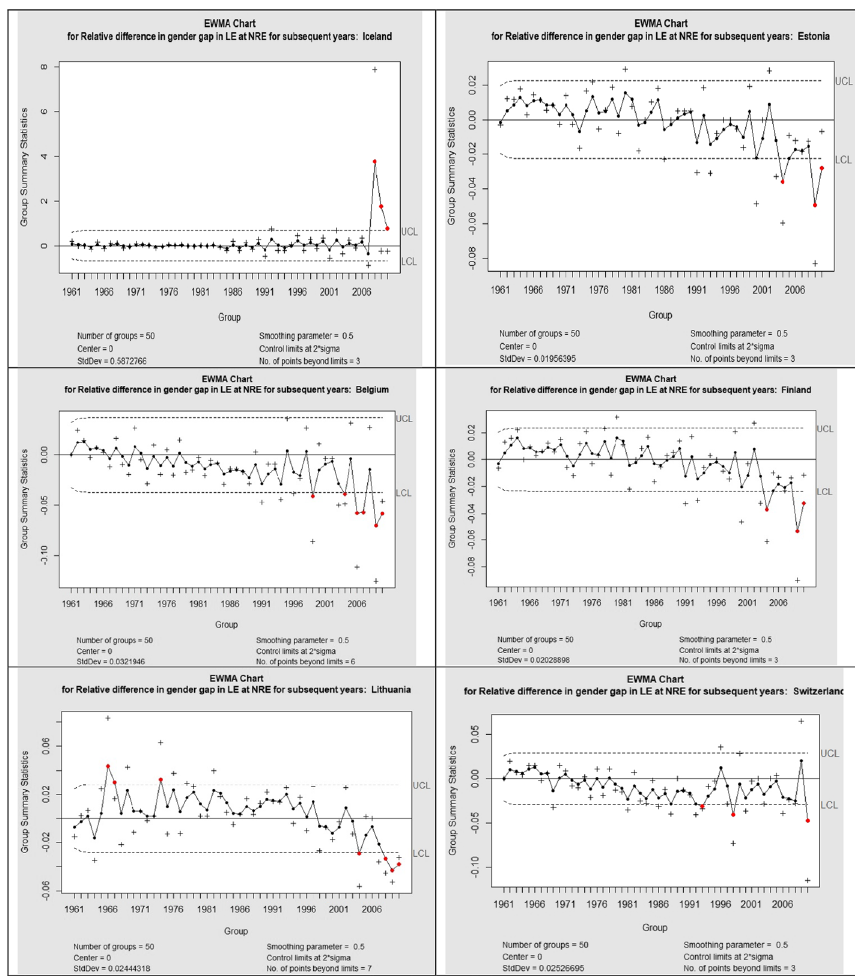
Fig. 6 Supplements to Fig.